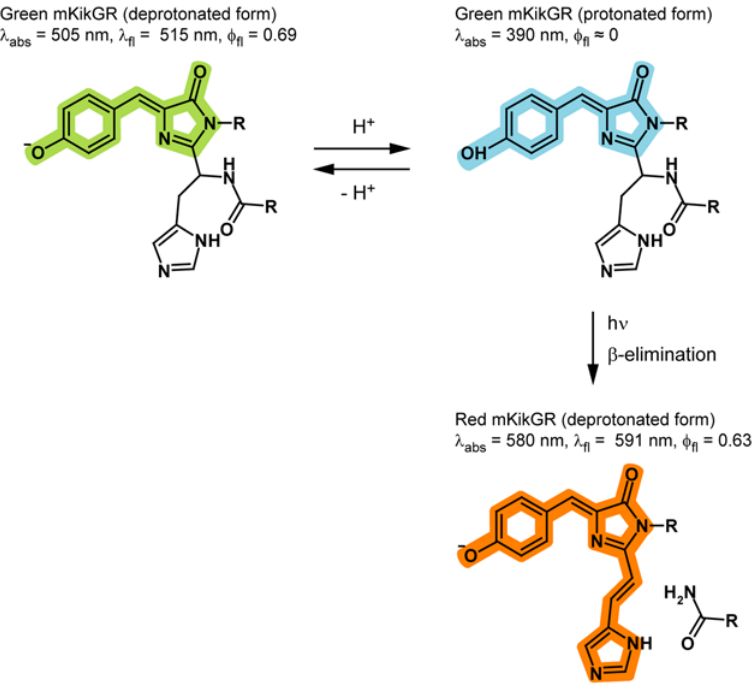
Figure 4. Reaction scheme of the photoswitching from the green to red mKikGR.